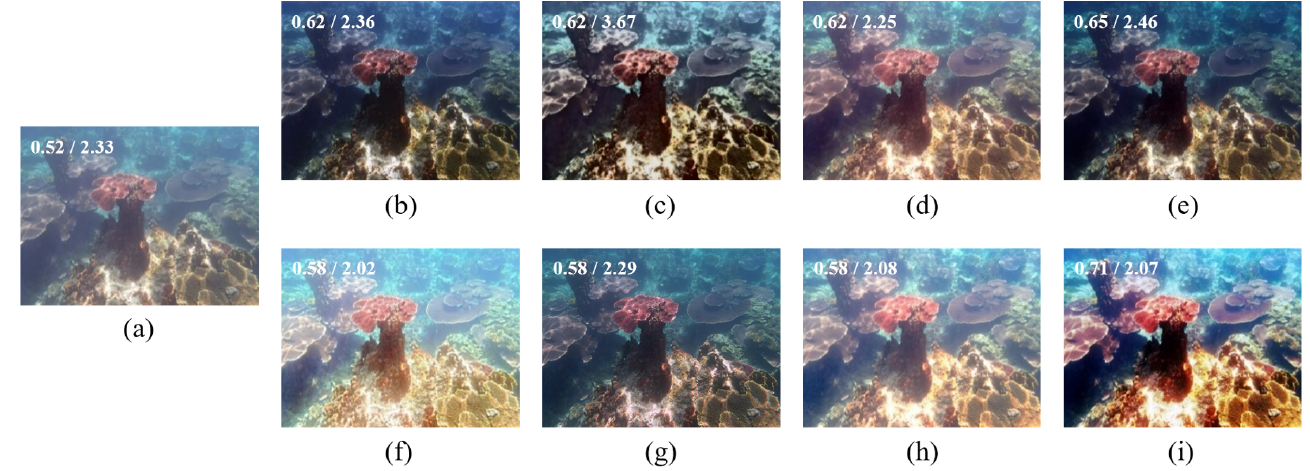
Figure 3. ( a ) Dark bluish underwater image, and its restored/enhanced results obtained using ( b ) Fusion-based[43], ( c ) Retinex-based[44], ( d ) IBLA[10], ( e ) AGC[45], ( f ) GDCP[9], ( g ) UWCNN[26], ( h ) BL-TM[40], and ( i ) the proposed method. The number on the top-left corner of each image refers to its UCIQE/NIQE score.